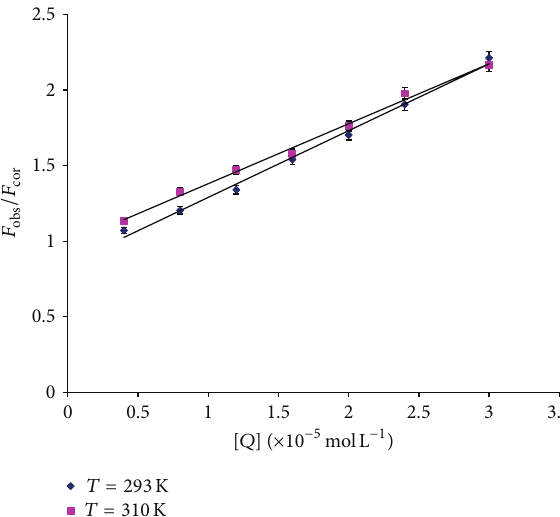
Figure 3: Stern-Volmer plots for the quenching of HAase by liquir- itigenin at different temperatures ( 𝑛 = 3